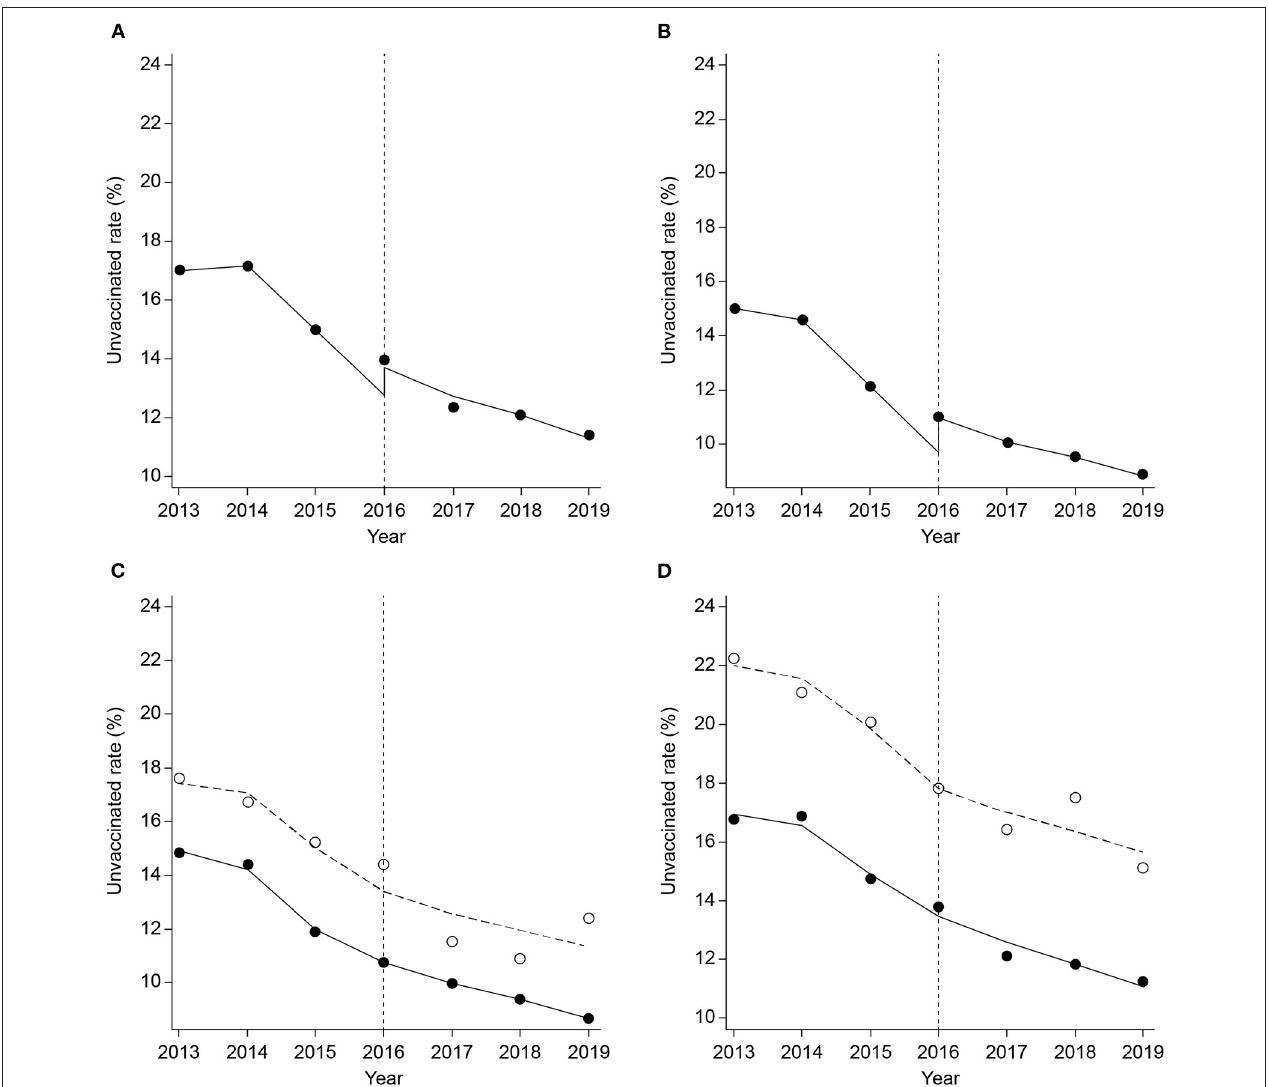
FIGURE 1 | Change in the unvaccinated rate before and after the contracting out of the National Immunization Program [ (A) : male; (B) : female; (C) : male by the type of health coverage; (D) : female by the type of health coverage; (C,D) : solid line indicates health insurance beneficiaries and dashed line indicates medical aid